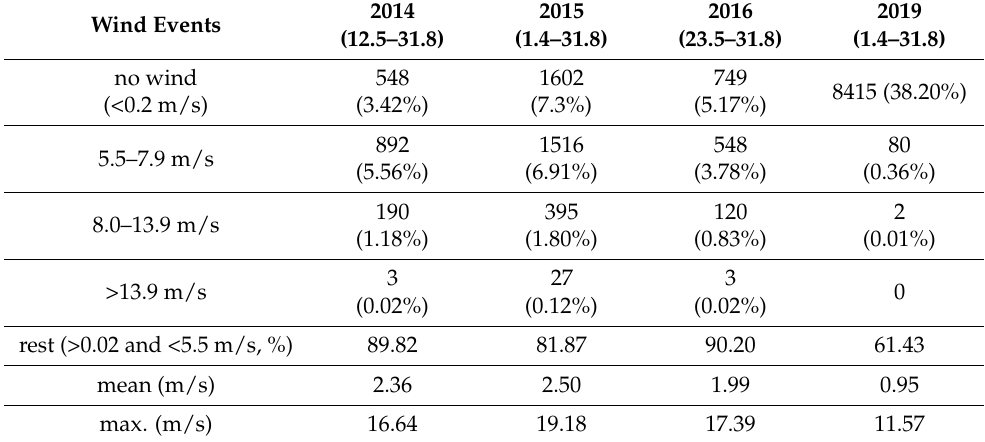
Table 1. Frequency of selected wind events based on the data on wind speed from an automatic sensor station (10 min measurement interval). Absolute counts of each event in each year, along with their share in total numbers of records, are